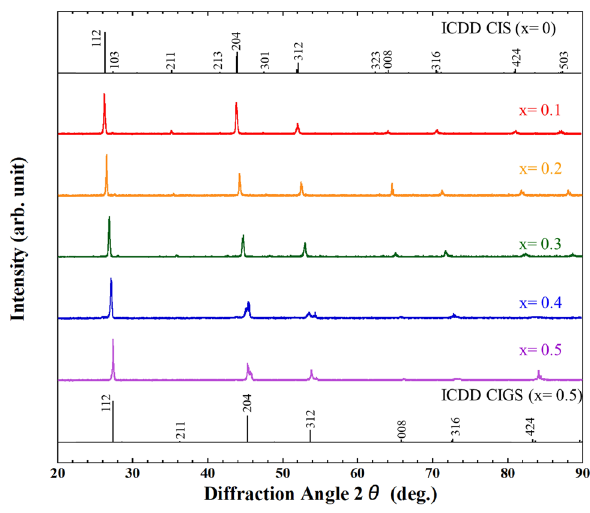
Figure 2: Powder XRD patterns of CIGS single crystals ( Ga content x = 0.1 – 0.5 ) .